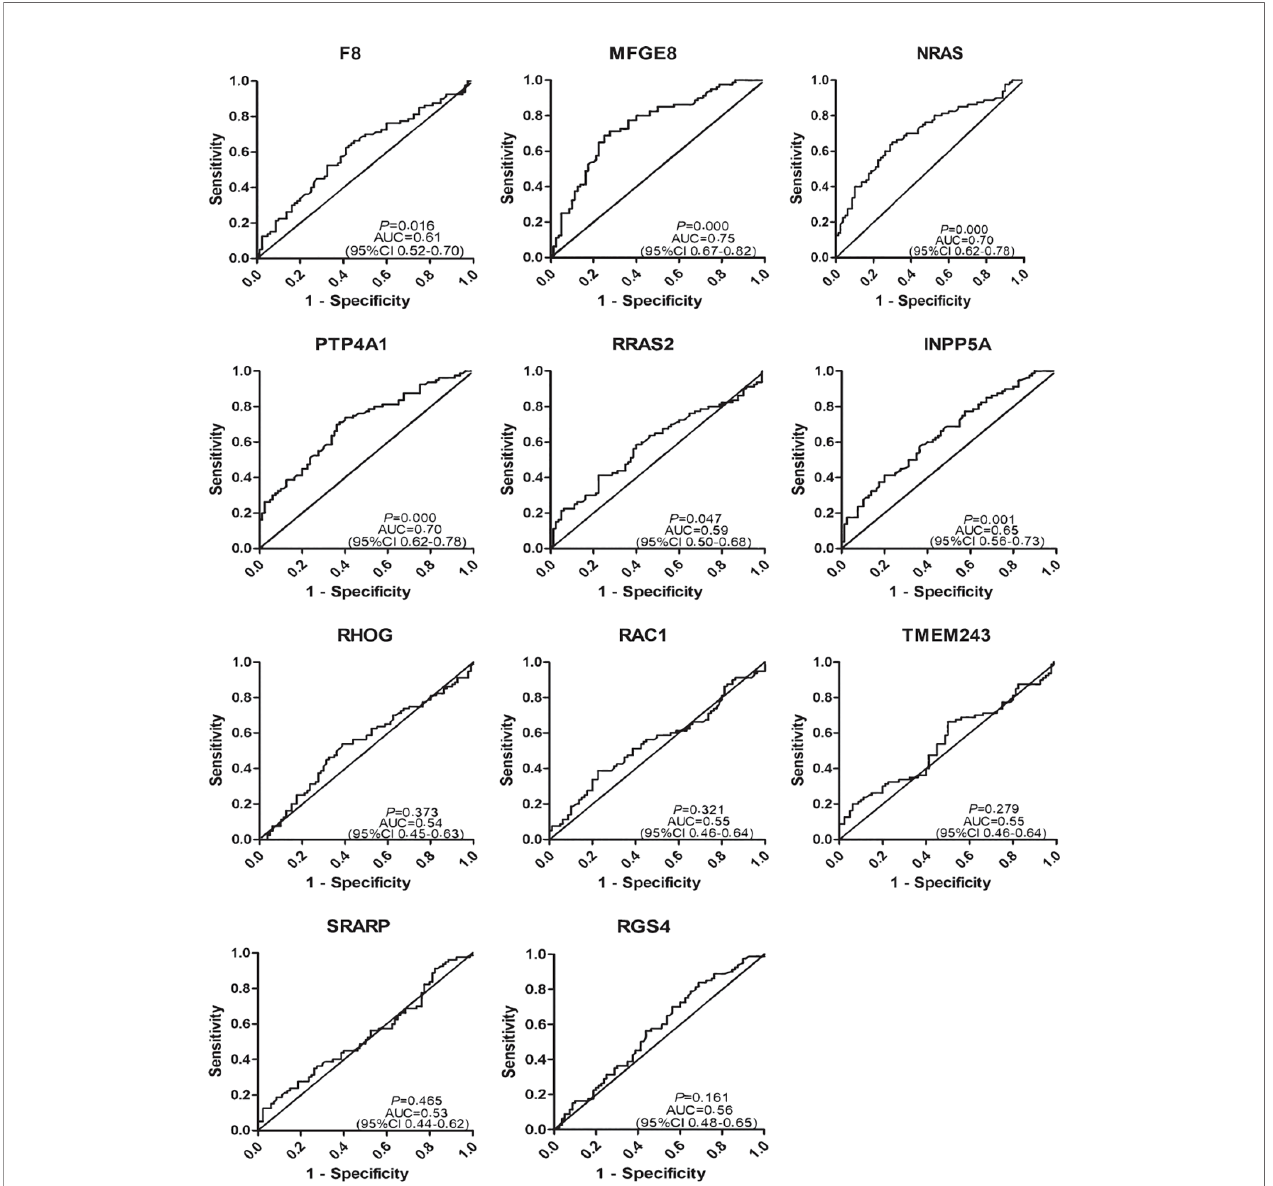
FIGURE 3 | Diagnostic performance of 11 anti-TAAs in the veri fi cation cohort for gastric cancer (GC)